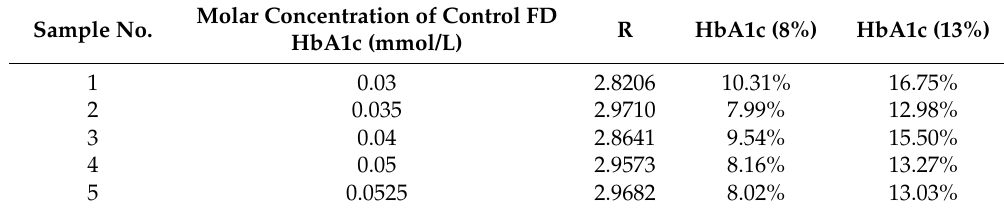
Table 1. Estimated percentage of glycated